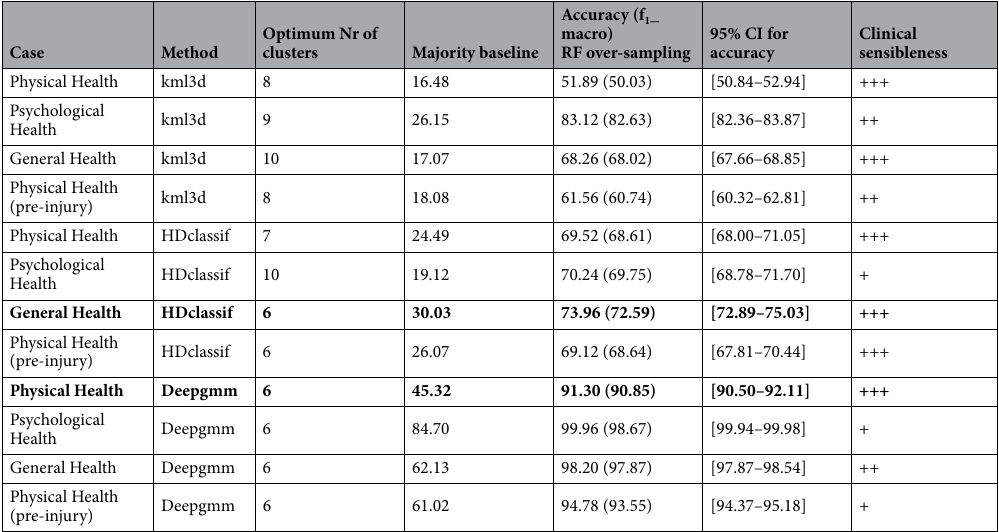
Table 3. Summary of classification results and quality assessment for clusters obtained from longitudinal data. Best models based on classification metrics and clinical sensibleness are in